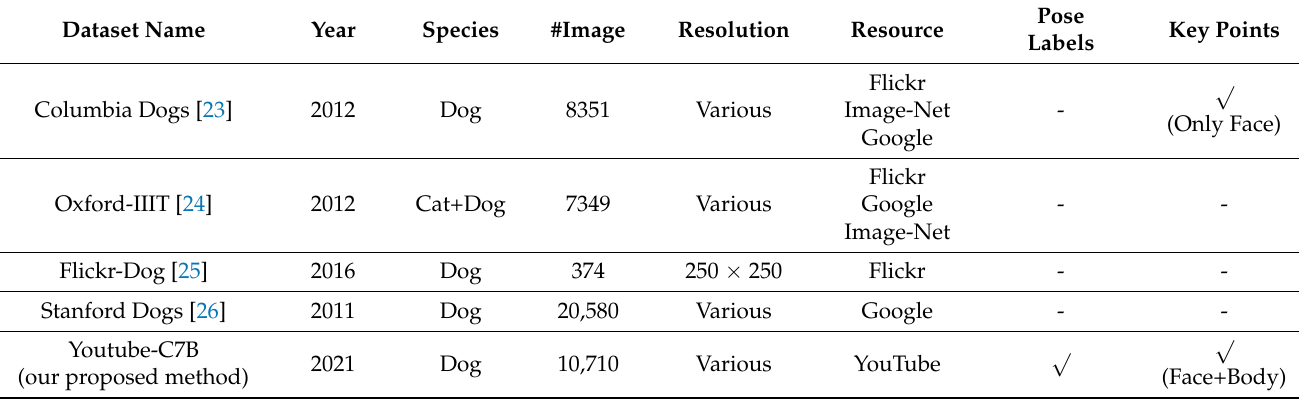
Table 1. Comparison of dataset.